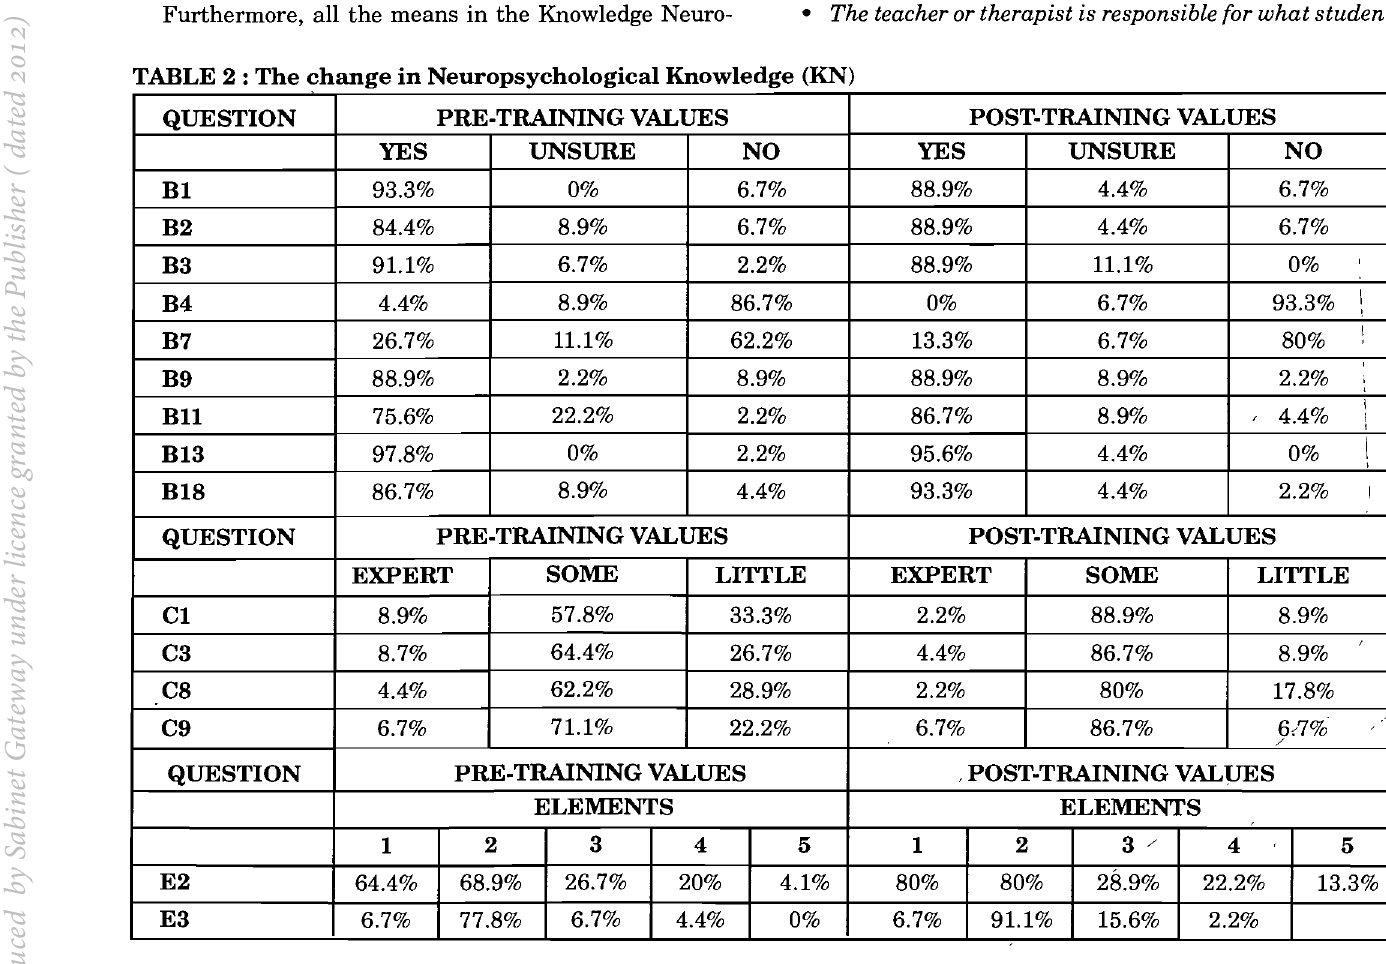
TABLE 2 : The change in Neuropsychological Knowledge (KN)